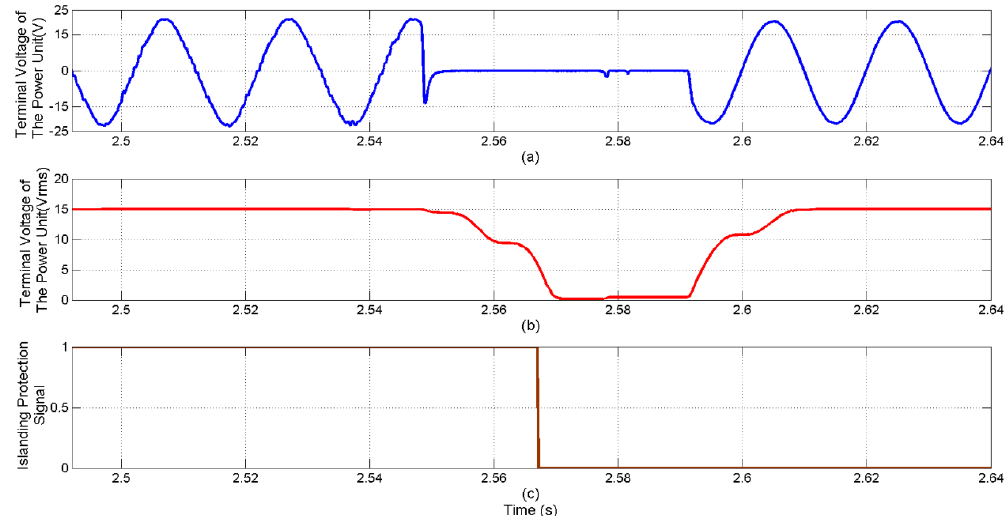
Figure 17. The waveform of the terminal voltage of the power unit when the power grid is powered up again. ( a ) Terminal voltage of the power unit [V] ( b ) Terminal voltage of the power unit [Vrms] ( c ) Islanding protection signal.